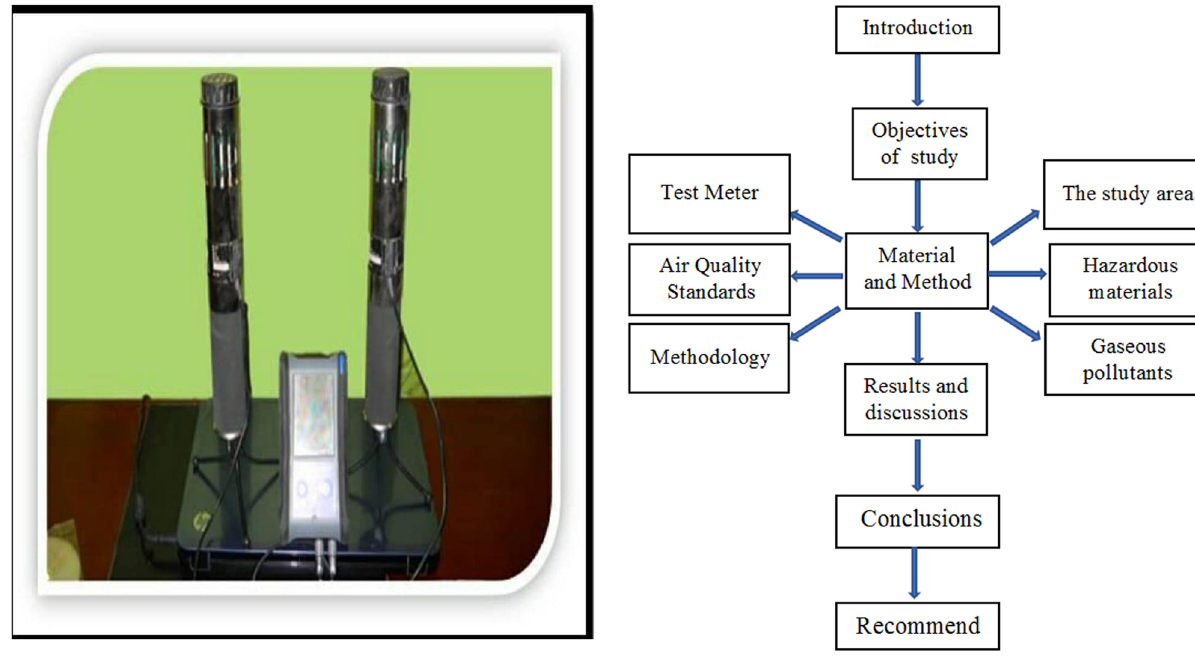
Figure 3: The research